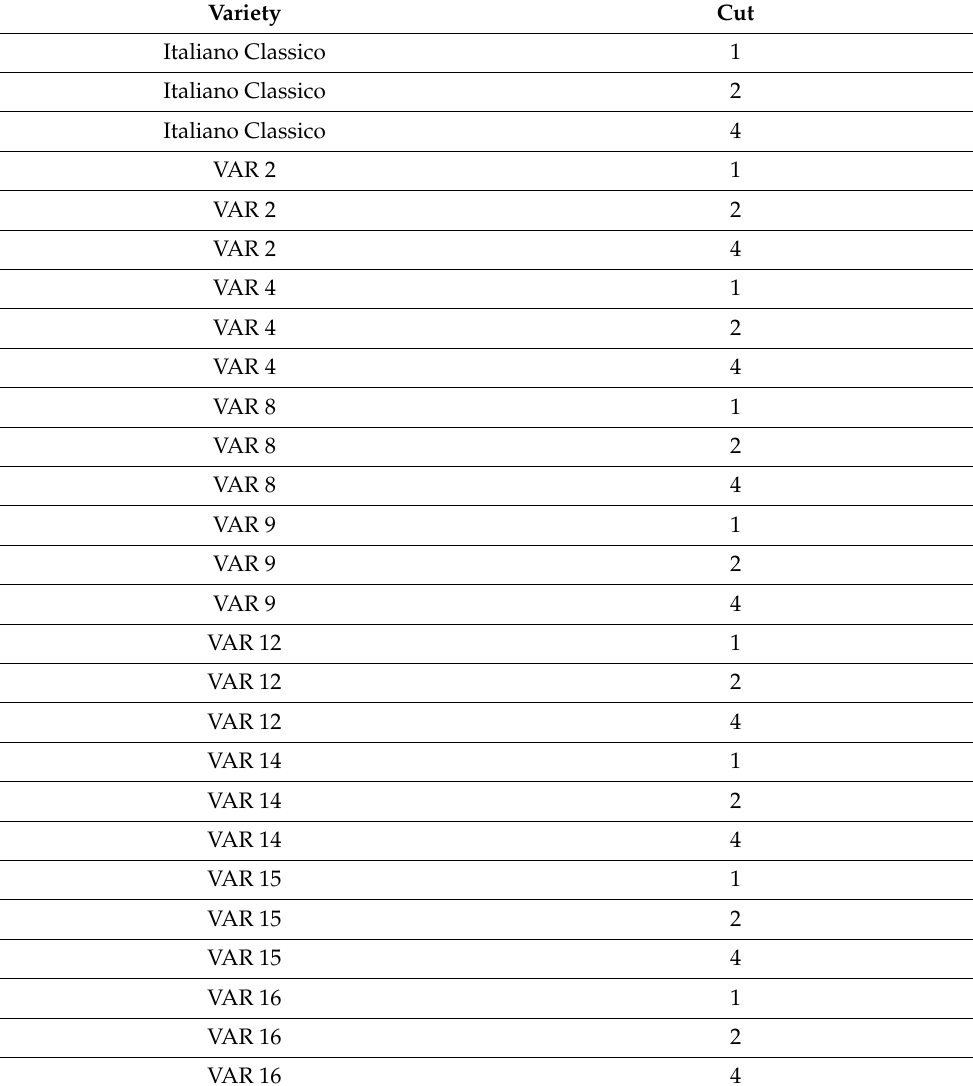
Table 3. Structure of the experimental design for ASCA for the year 2021.